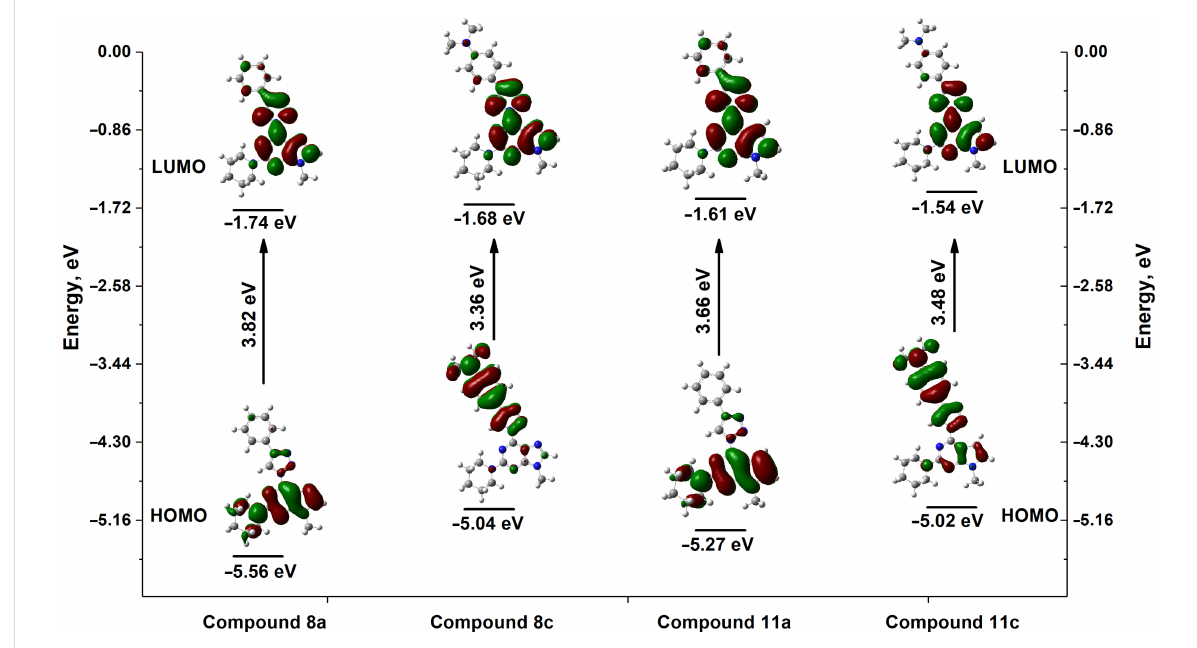
Figure 7: Energy diagram for the frontier molecular orbitals of compounds 8a , 8c , 11a and 11c